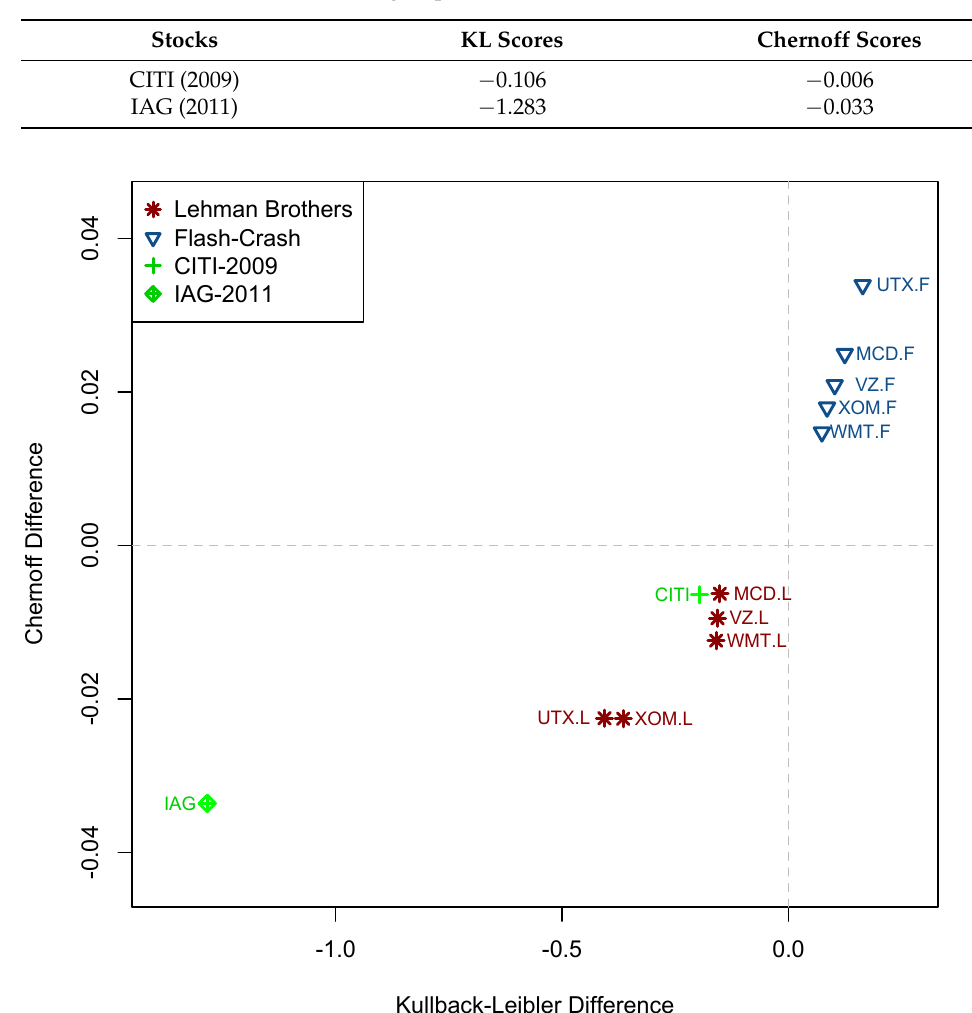
Table 16. Discriminant scores for Citigroup in 2009 and IAG stock in 2011.